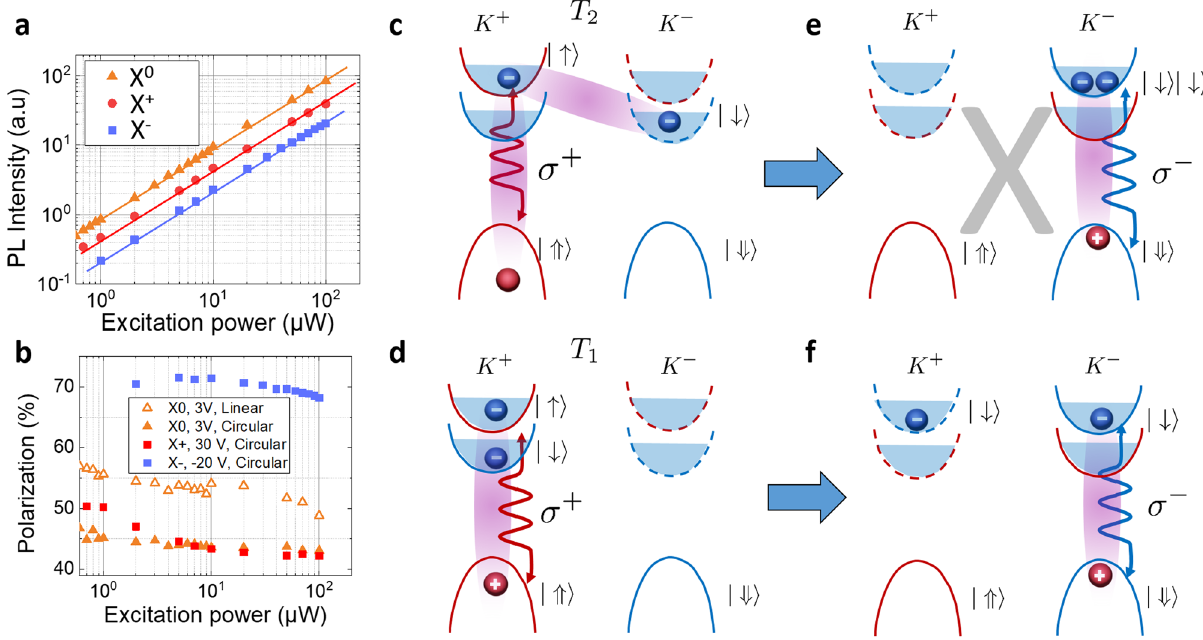
Fig. 4 Bandstructure of MoS 2 monolayer and valley relaxation of negatively-charged trions. a Integrated intensity as a function of excitation power. The error bars are two small to be visible and obtained through the fi tting procedure of the photoluminescence (PL) intensity of each excitonic peak, which is the limitting factor here due to the high power-stability of the excitation laser. b Degree of polarization as a function of excitation power. The error bars are not visible since the error in the polarization is smaller than 1 percent thanks to the laser power stability and callibration of the waveplates. c Schematics of a negatively charged trion in the K + valley corresponding to a spin singlet state in which both electrons reside at opposite valleys. Here T stands for trion and σ represents a circularly-polarized photon state. d Negatively charged trion in the K + valley corresponding to a spin singlet state in which both electrons reside in the same valley K + . e State obtained after moving the exciton from the K + to the K − valley for the trion depicted in ( c ). This state is forbidden by the Pauli principle. f State obtained after moving the exciton from the K + to the K − valley for the trion depicted in ( d ). The continuous (dashed) lines represent the ordering of the conduction bands in the excitonic (single-particle)